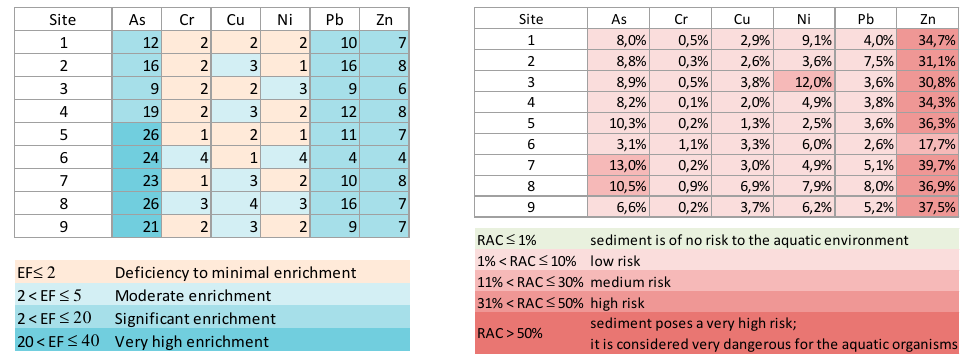
Figure 3. Enrichment factors (EF) of metals and risk assessment code (RAC) of bottom sediments from the Terragido reservoir.